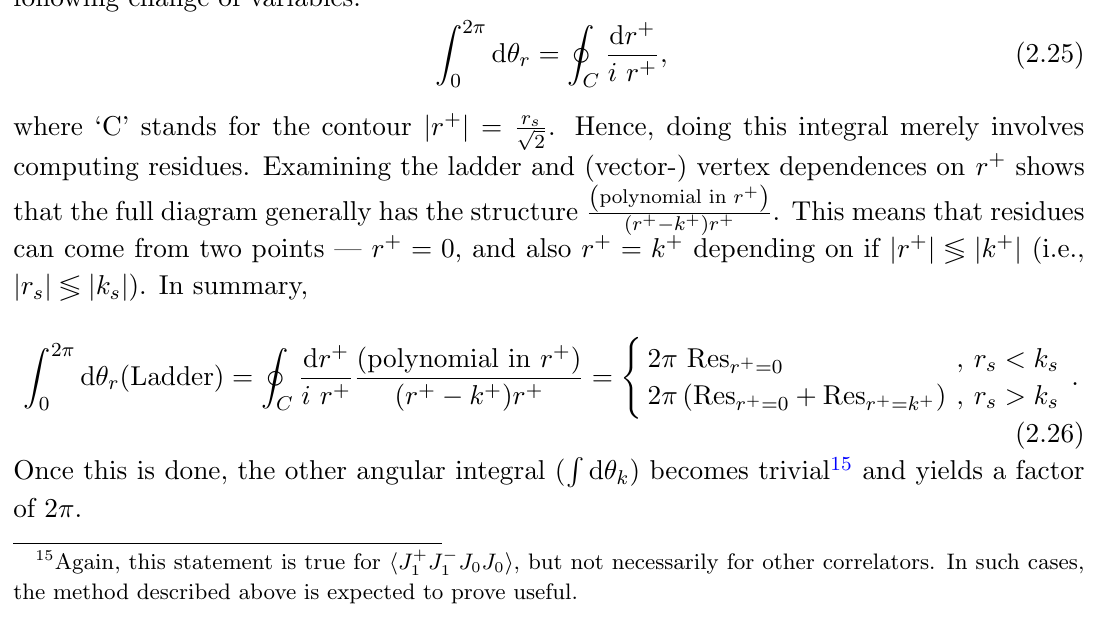
Figure 3. The ladder diagrams that contribute to h J + in the name stands for the fact that these are ladder diagrams. The second letter stands for the exchange momentum, and changing the number at the end permutes the vertices on each side of the four-point